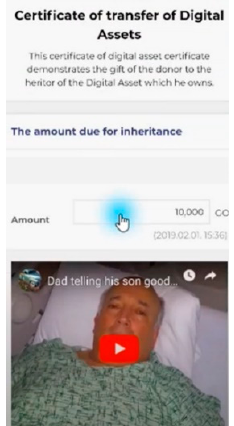
Figure 13. Legacy inheritance verification screen.